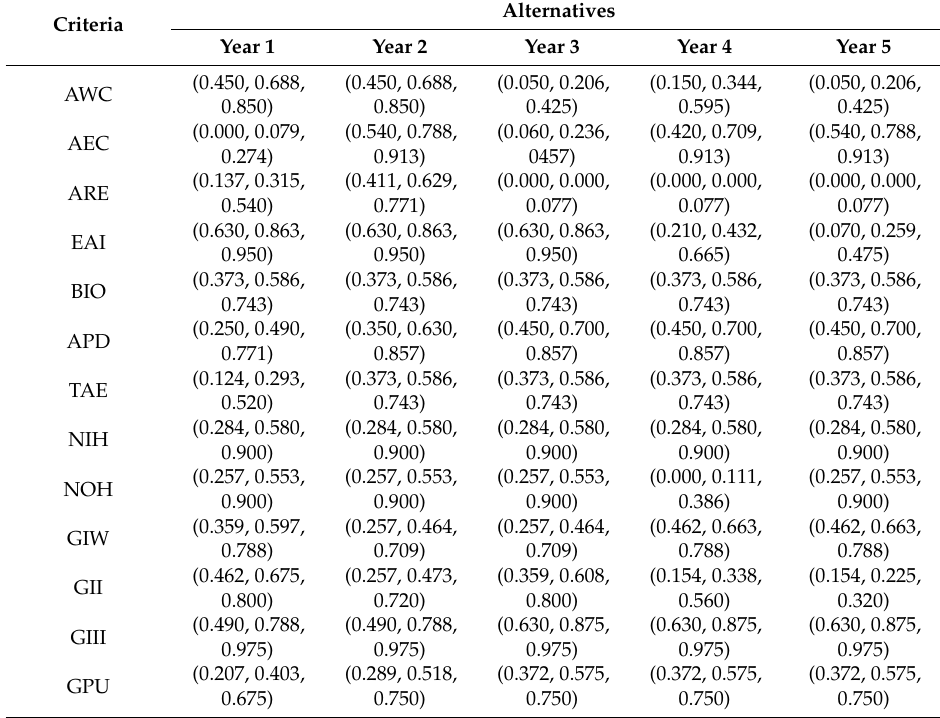
Table 6. The fuzzy weighted normalised decision matrix obtained from the patient group judgements.